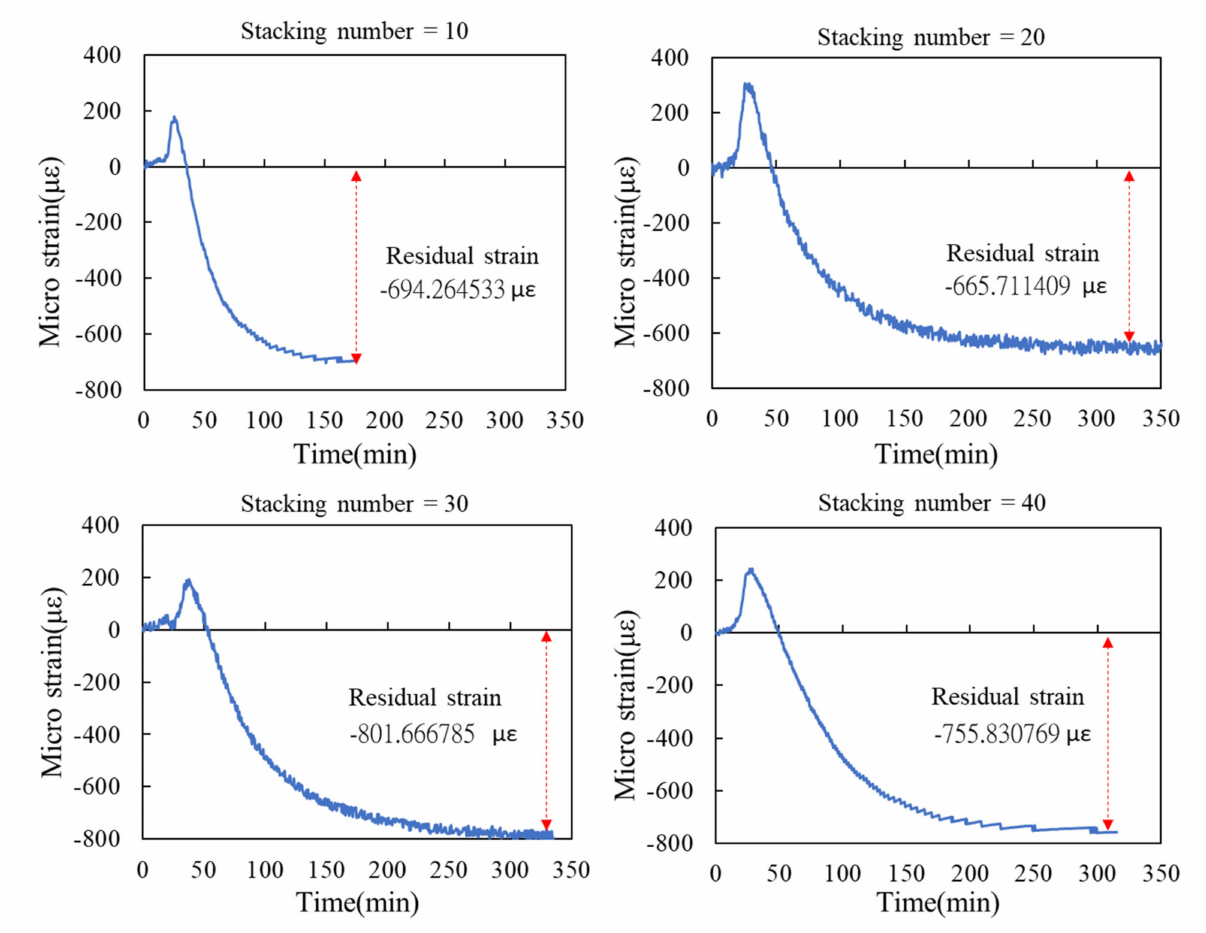
Figure 15. Residual strains of symmetrical layer.